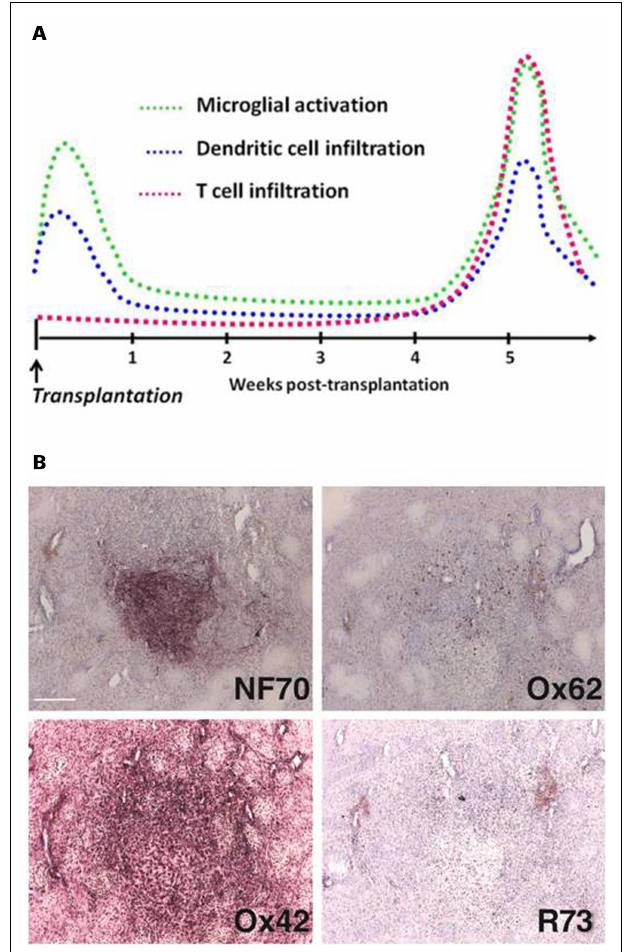
FIGURE 1 | Characterization of xenograft infiltration by activated immune cells. Kinetics (A) . In the absence of immunosuppressive treatment, the rejection process of fetal neurons xenografted in the rat striatum involves cells from the macrophagic lineage. After a peak of microglial activation and dendritic cell infiltration in the first days post-transplantation, probably consecutive to the surgery, a latency phase is observed. Around 5 weeks post-transplantation, rejection process is initiated and strong microglial cell activation at the border but also within the graft is observed.This phenomenon is strongly correlated with a massiveT cell and dendritic cell infiltration. Immunostaining (B) . Specific porcine neurofilament is revealed by NF70 antibody and allows visualization of the graft. Immune reaction is assessed by Ox62 (dendritic cells), Ox42 (microglial cells/macrophages), and R73 (T cells) antibodies. Scale bar: 200 μ